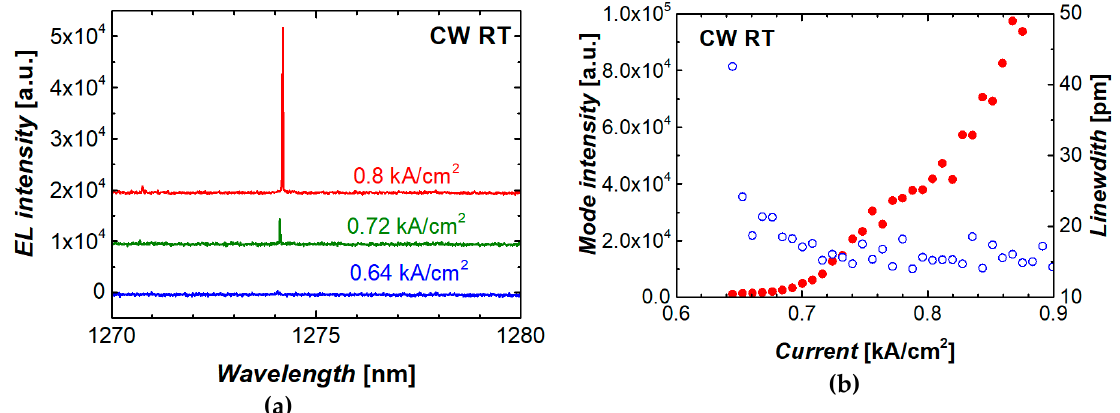
Figure 12. Evolution of emission spectrum near lasing threshold ( a ), mode integrated intensity (solid symbols) and linewidth (open symbols) against injection current ( b ) for microdisk laser transferred to silicon wafer .